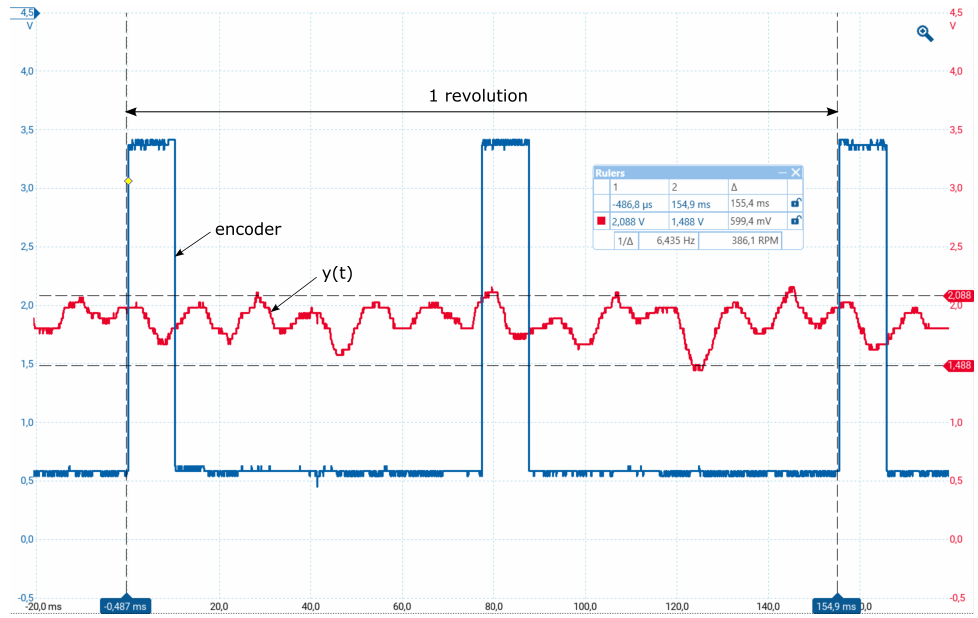
Figure 2. Two incremental sensor pulses (blue) specifying one revolution and the output velocity from tachodynamo with 12 maxima/minima per revolution (red), measured with T sm = 0.1